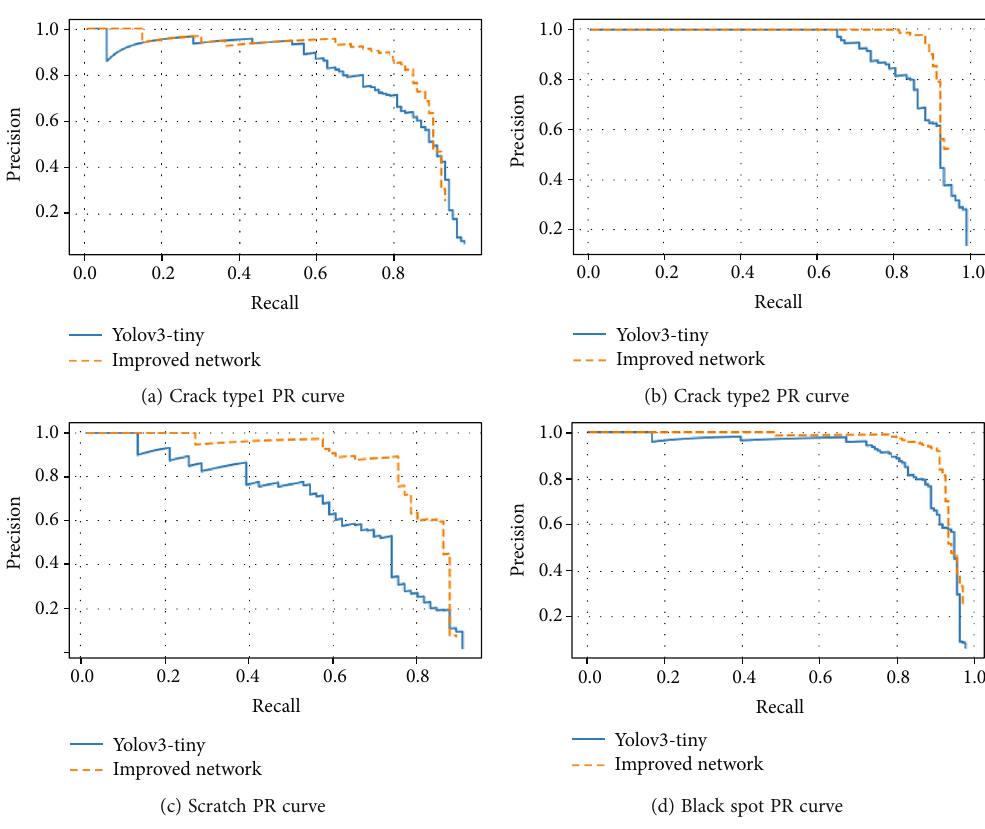
Figure 13: PR curves of YOLOv3-Tiny and improved network. Table 4: Performance comparison of di ff erent network models. Network